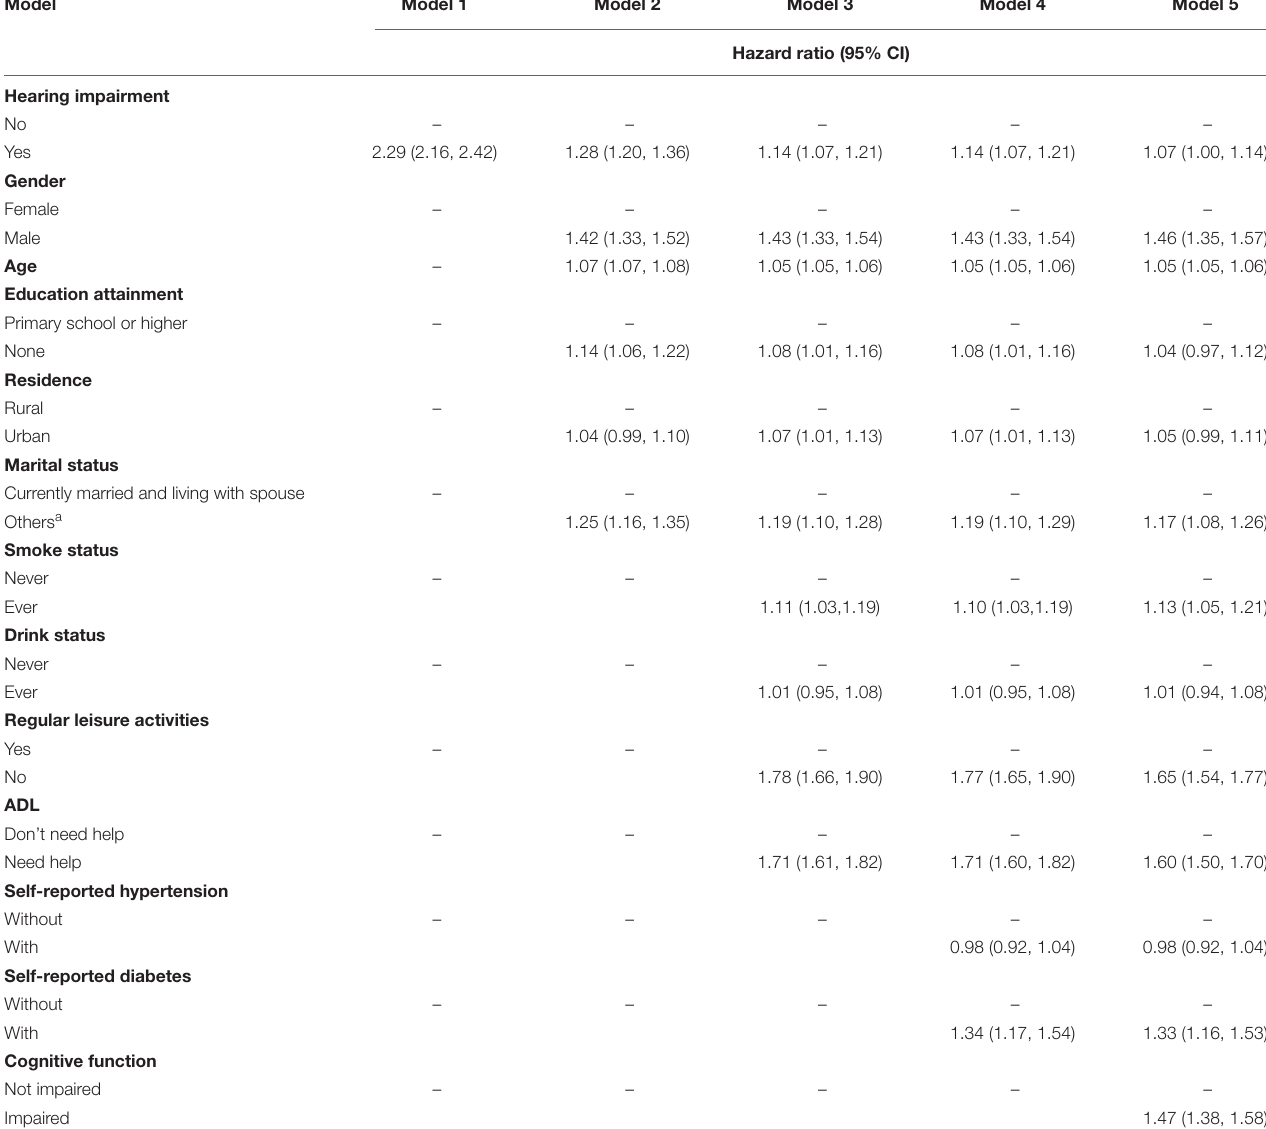
TABLE 2 | Multivariable-adjusted hazard ratios and 95% confidence intervals of all-cause mortality by hearing